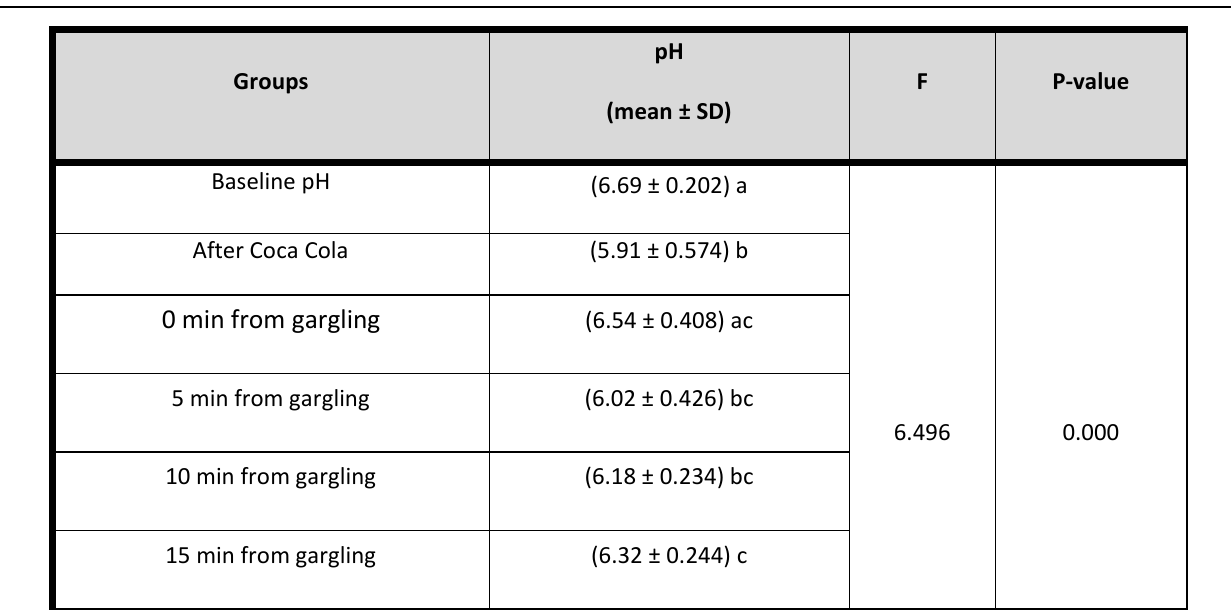
Table 5. One way ANOVA of salivary pH after green tea mouthwash